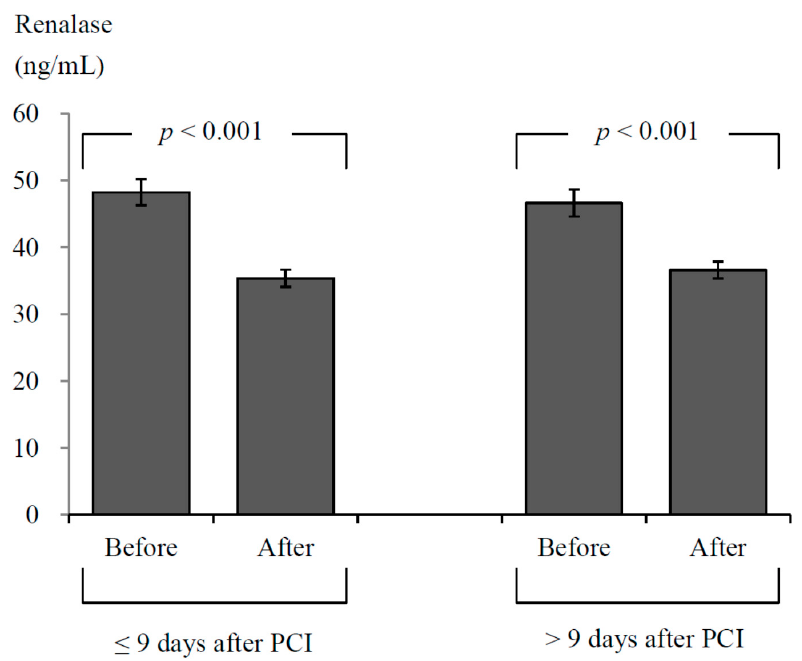
Figure 2. Serum renalase concentrations before and after percutaneous coronary intervention (PCI) in patients who underwent outpatient renalase assessment within nine days of PCI ( n = 87) and >9 days after PCI ( n = 65). Mean and standard error of serum renalase levels are shown. To assess the effects of the associated factors at baseline on the change in serum renalase levels after PCI, all patients were assigned to either the renalase reduction group or reference group, according to the median percentage change in serum renalase levels (22%). The median duration between PCI and outpatient visit was not significantly different between the renalase reduction group and the reference group ( p = 0.615). Higher baseline serum BDNF levels were observed in patients with serum renalase reduction ≥ 22%, as compared to the other patients (27.0 ± 10.1 vs. 22.4 ± 11.3 ng/mL, p = 0.009; Table 3). Figure 3 shows that the percentage change in serum renalase levels was inversely correlated with the baseline serum BDNF levels ( r = − 0.243, p = 0.003).